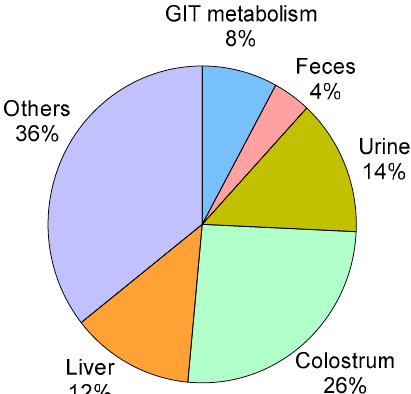
Figure 5. β -hydroxy- β -methyl butyrate (HMB) distribution in sow tissues and metabolites (liver, gastrointestinal tract, colostrum, urine, feces, and others) refer to dietary HMB intake. GIT, gastrointestinal tract. The amount of HMB secreted into colostrum is calculated under the assumption that it is taken up by the mammary gland at the day of farrowing [26] . At day − 10 and − 3, the 26% representing colostrum most likely contributes to “Others”, as this category is calculated as a difference.